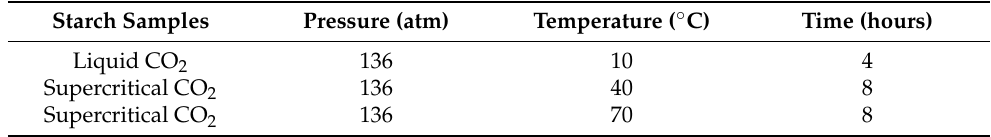
Table 1. Operating conditions of supercritical CO 2 procedure. Starch